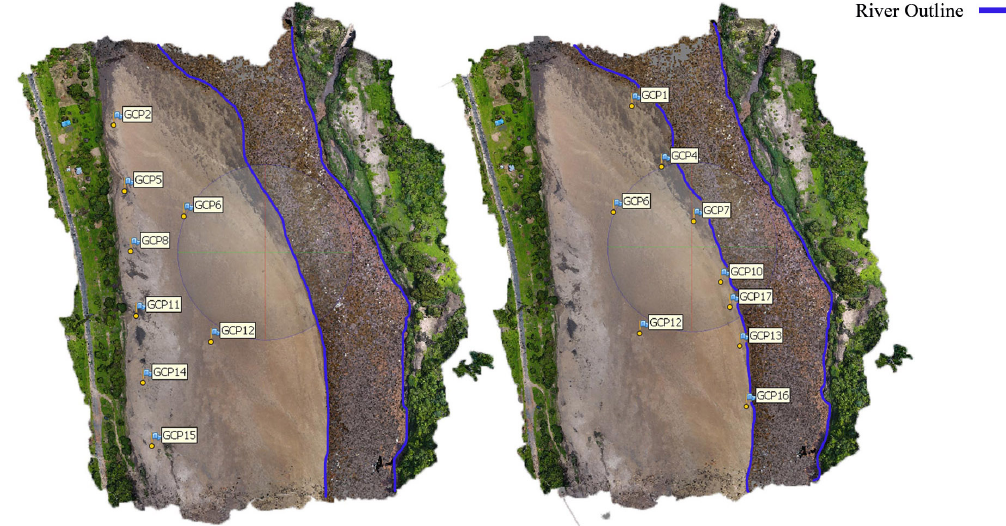
Figure 8. GCP marker distribution closer to and further from the river as well as the wetted river perimeter measured during the survey, projected on an orthophoto result.